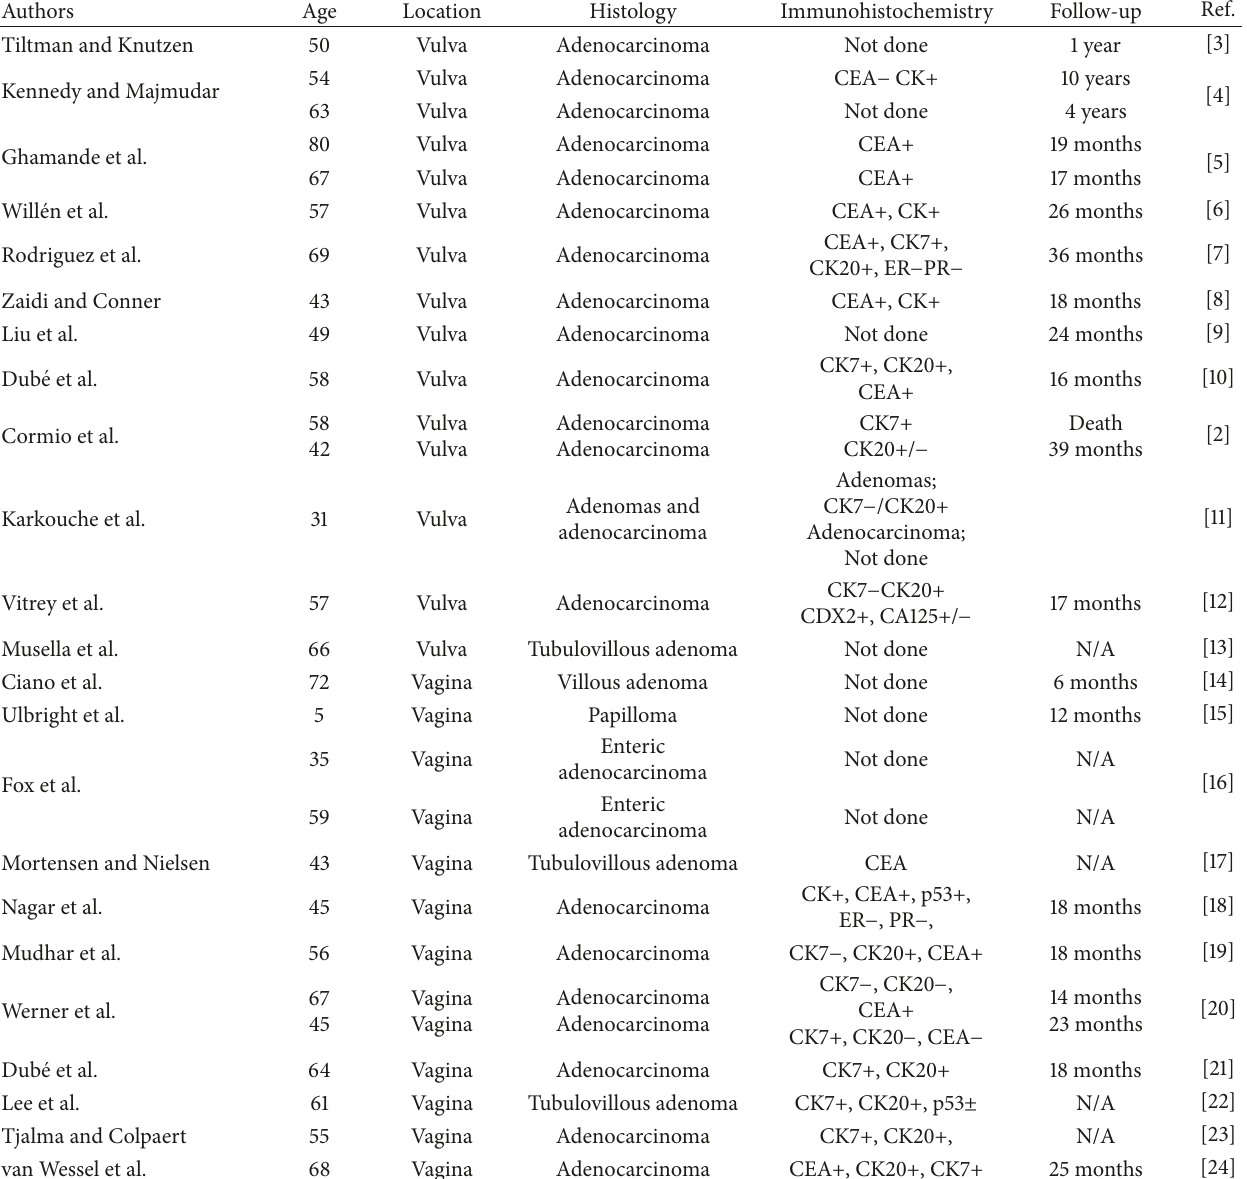
Table 1: Reported cases of enteric type tumor in female lower genital